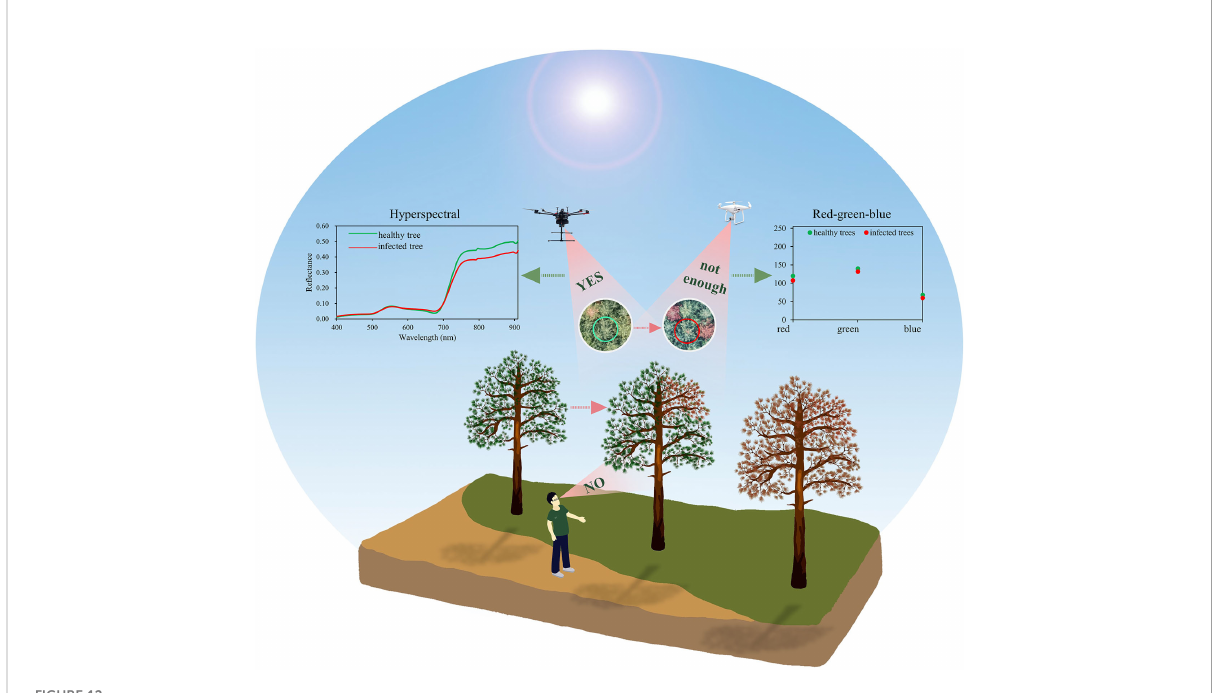
FIGURE 12 A schematic diagram of tree crown changes and the limited range of human